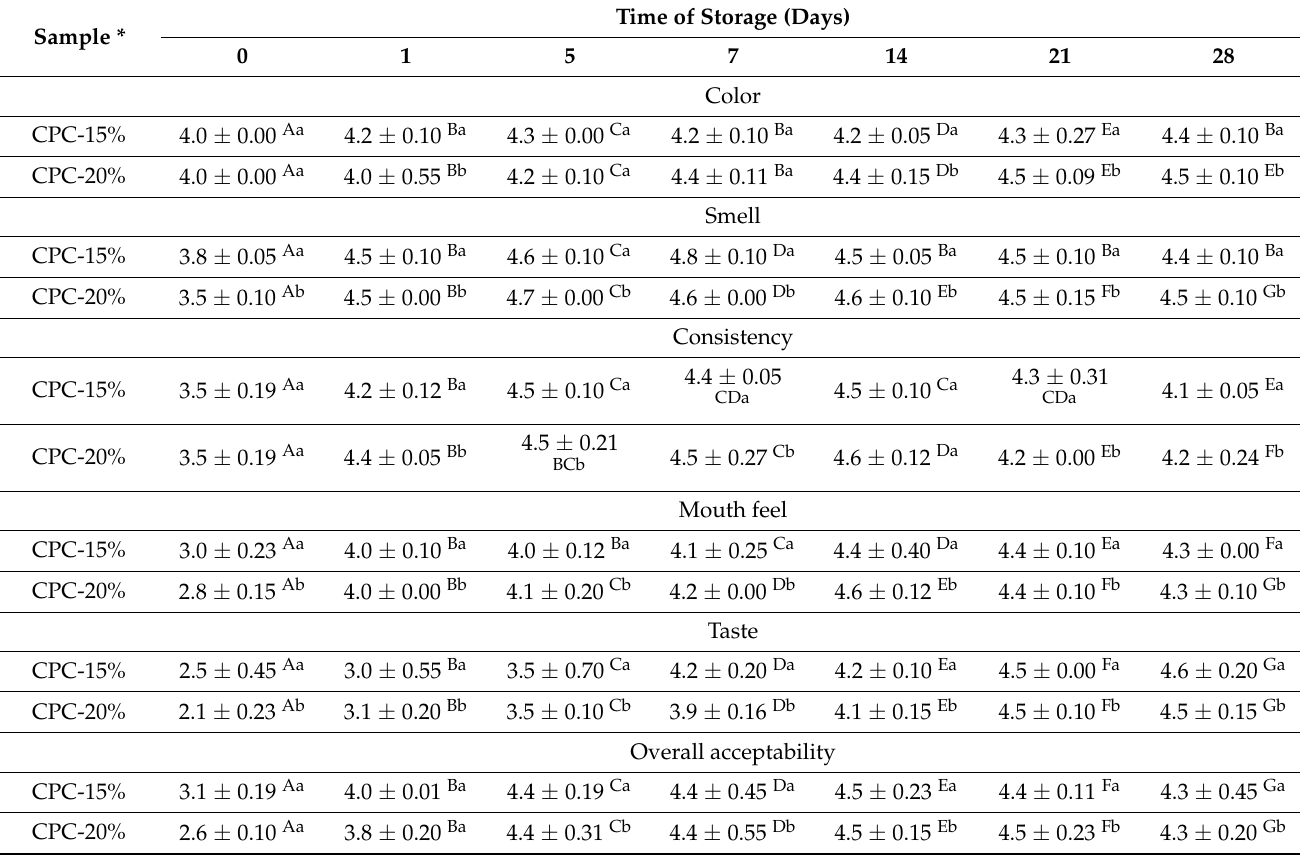
* CPC-15%—sample with 15% ( w / w ) camelina press cake content, CPC-20%—sample with 20% ( w / w ) camelina press cake content; values are means ± standard deviation of triplicate determinations by 10 panelists. Means with different lowercase in the same column are significantly different at p < 0.05. Means with different uppercase in the same row are significantly different at p <